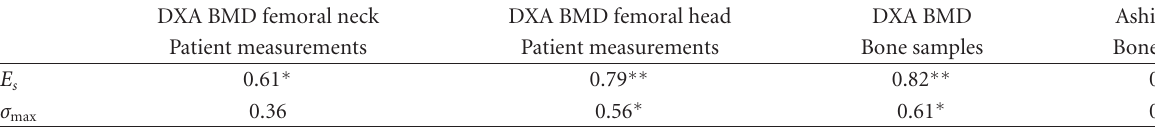
Table 3: Linear correlation between BMD (DXA and ashing) and mechanical properties (structural modulus ( E s ) and ultimate compression strength ( σ max )).